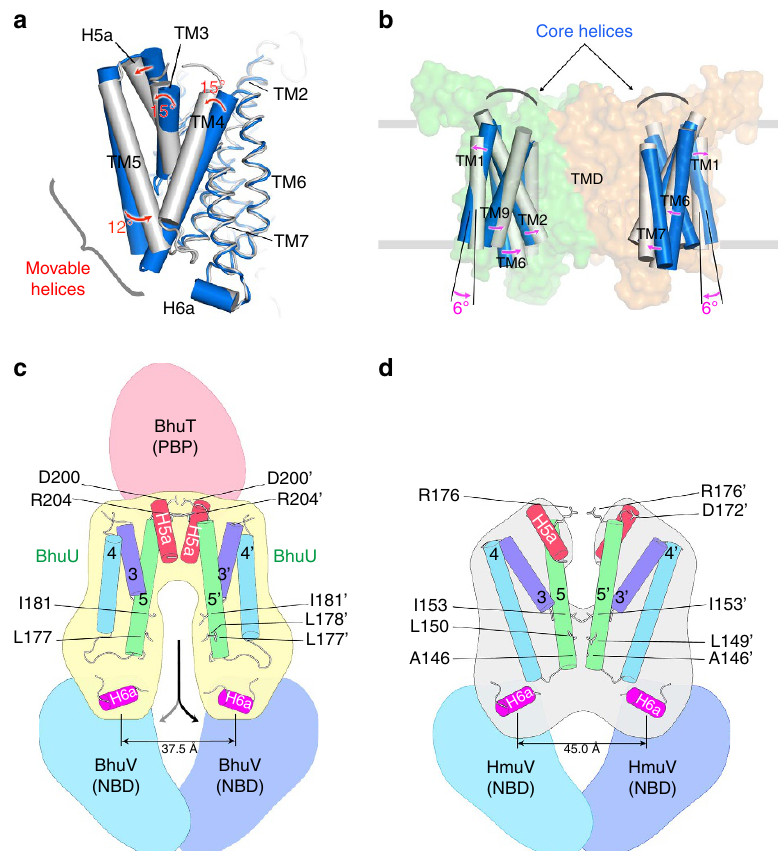
Figure 5 | Conformational changes between the inward- and outward-facing structures of the haem transporter. ( a ) Superposition of the BhuU and HmuU monomers. The C a atoms of the core TM helices (TM1, 2, 6–9) are used for superposition (r.m.s.d. 0.8Å for 135 C a atoms). TM3-5 and H5a show large deviations and are represented by cylinders for clarity. BhuU and HmuU are grey and blue, respectively. ( b ) Superposition of the BhuU dimer and HmuU dimer (r.m.s.d. 2.4Å for 260 C a atoms in the core TM helices). The core TM helices are shown as cylinders and TM8, TM10 and movable helices are omitted. The core TM helices can rotate as a unit by 6 (cid:2) . ( c ) Schematic diagram of the conformation of the movable helices (TM3-5 and H5a) in the inward-facing conformation of BhuUV-T. The distance between the H6a helices is measured from the C a atoms of A253 in the middle of H6a. The residues involved in the periplasmic and cytoplasmic gate are represented by stick models. ( d ) Schematic diagram of the outward-facing conformation of HmuUV. The distance between the H6a helices is measured from the C a atoms of A225 in the middle of